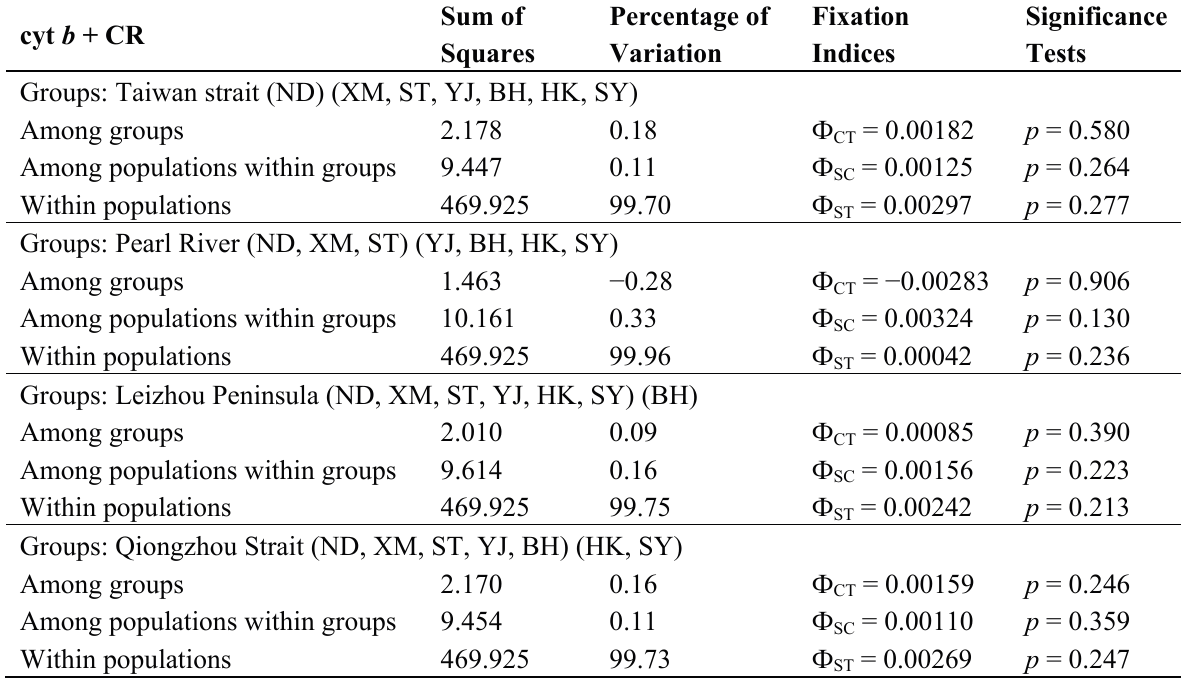
Table 3. Analyses of molecular variance (AMOVA) results for testing the genetic subdivision of populations using cyt b + CR sequences across geographic